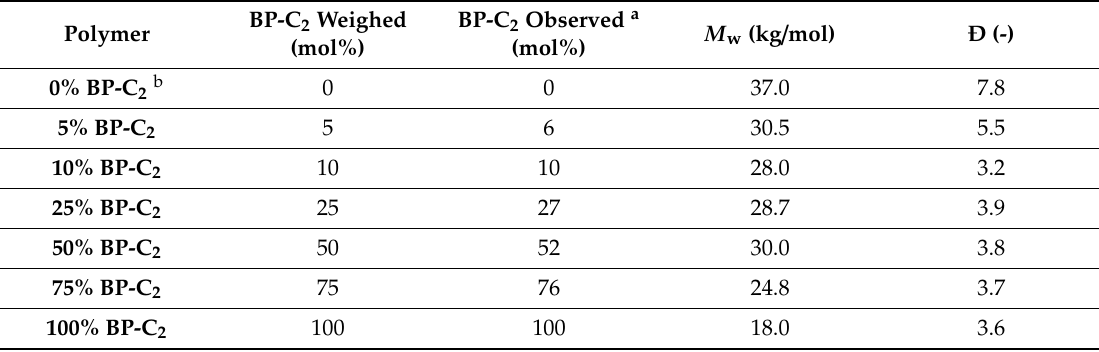
Table 1. Overview of the BP-C 2 content and the molecular weight ( M w ) and dispersity Ð, as determined from 1 H NMR and gel permeation chromatography (GPC) analysis,